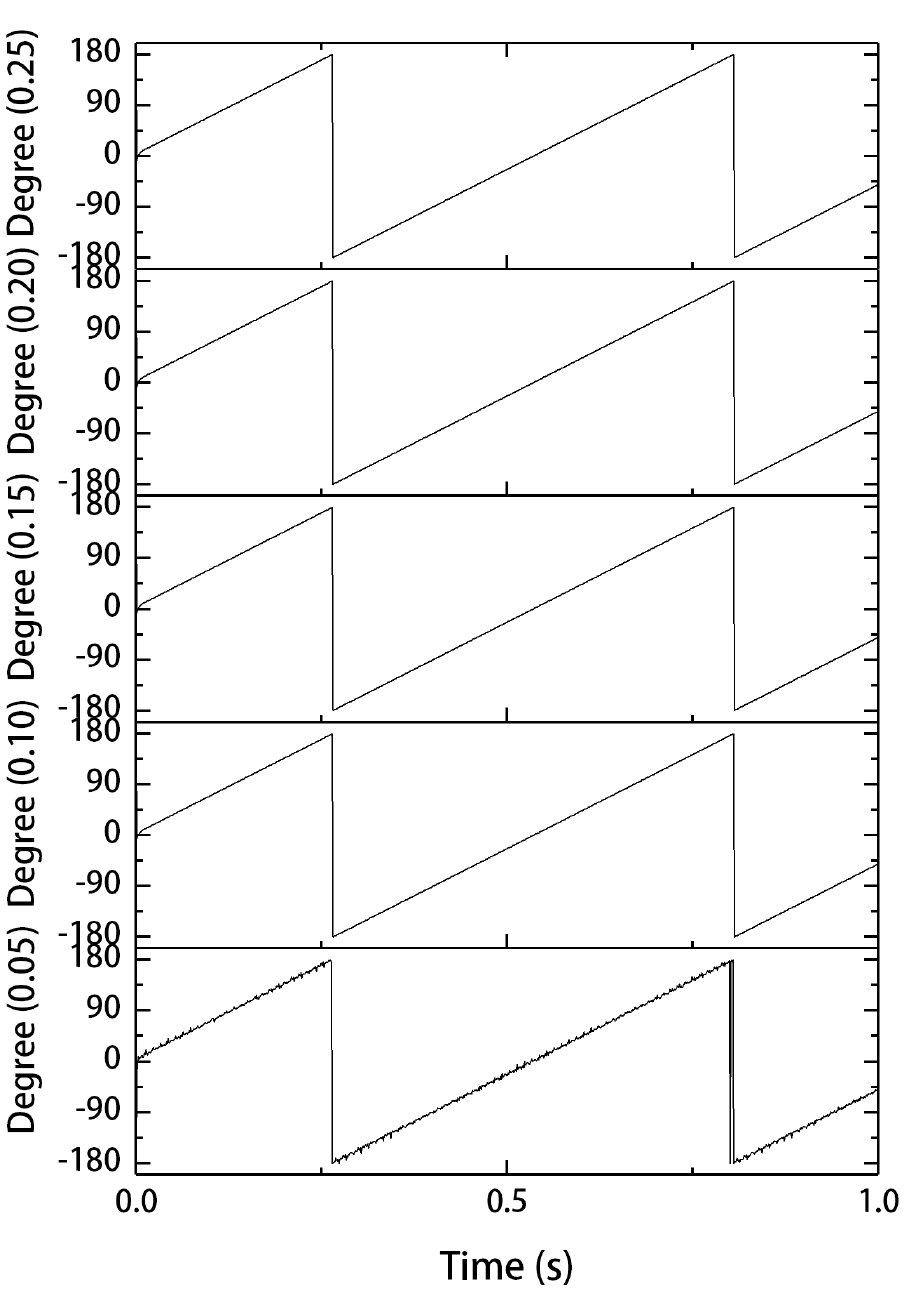
Figure 14. The direction of the unbalanced magnetic pull, varying with